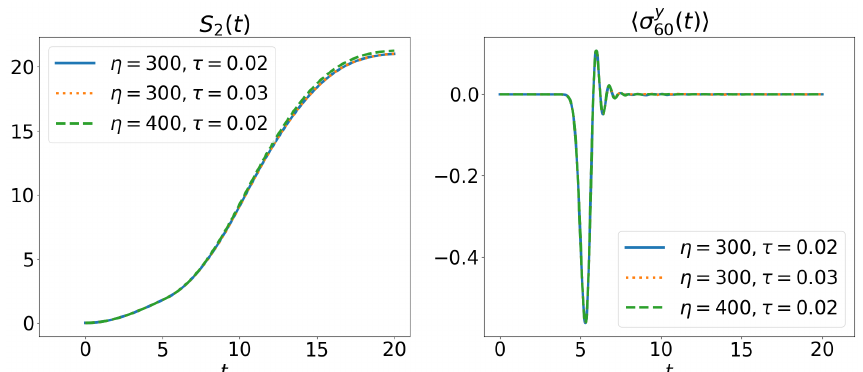
Figure 17: The second Rényi entropy S (left), and the Y expectation value for 2 = 0.1 as qubit 60 (right), for N = 61 qubits with energy relaxation parameter g 0 in Eq. (32), and the other parameters as in Figs. 2-3. A few solutions are shown vs. the time t , simulated with different values for the maximal bond dimension η and time step τ , with the convergence clearly